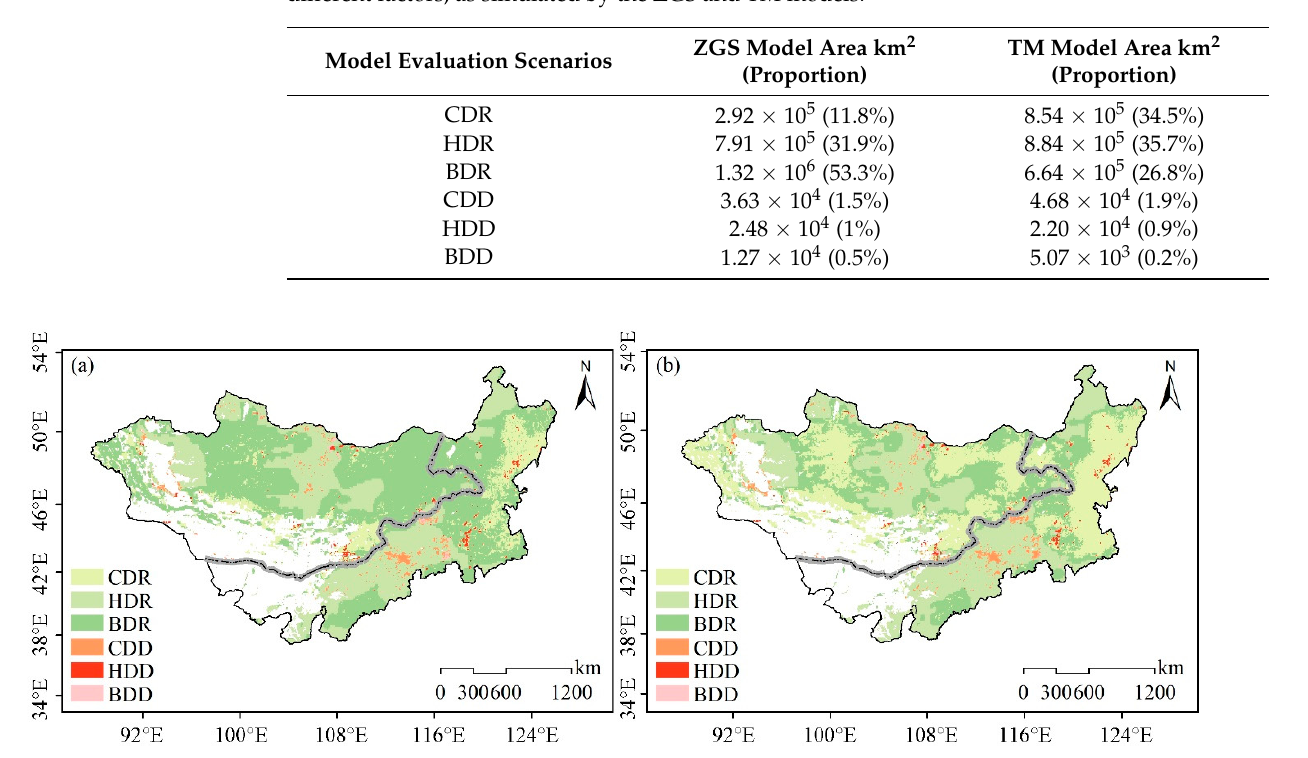
Figure 8. Relative effects of climate change and human activity on vegetation restoration and deg- radation: ( a , b ) represent the results of ZGS model and TM model, respectively.